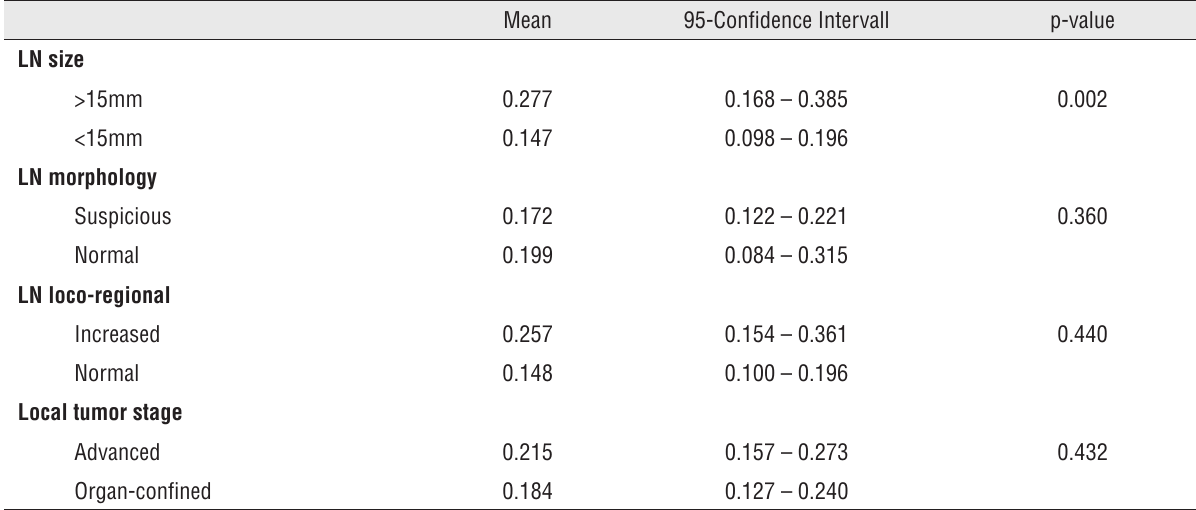
Table 2 - Impact of CT scan characteristics on